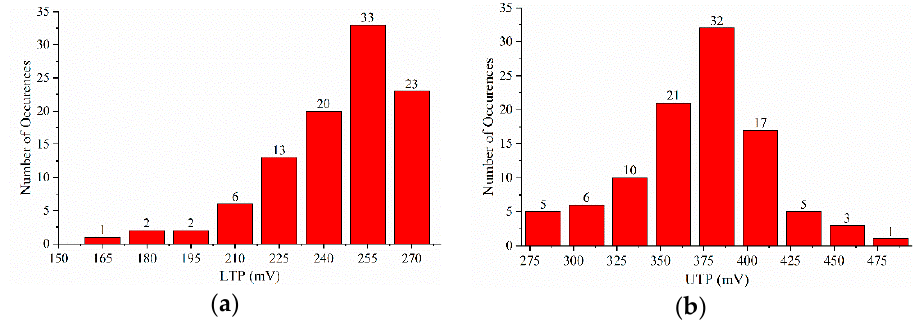
Figure 16. Post-layout simulated histogram for 100 runs of Monte Carlo for ( a ) LTP and ( b ) UTP.